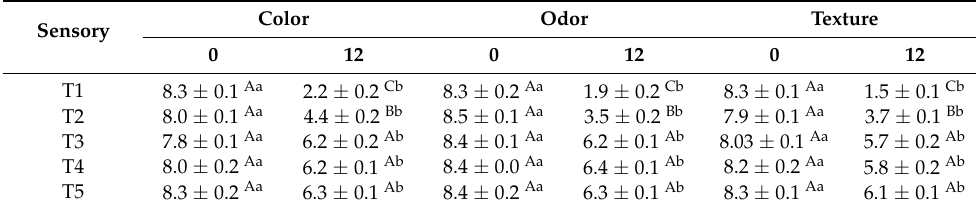
Table 3. The sensory evaluation of beef samples from different treatment groups during storage. (mean ± S.E.). Color Odor Sensory